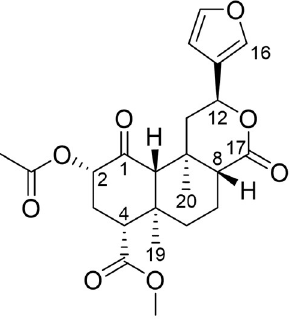
Figure 1. Chemical structure of Salvinorin A (SalA).